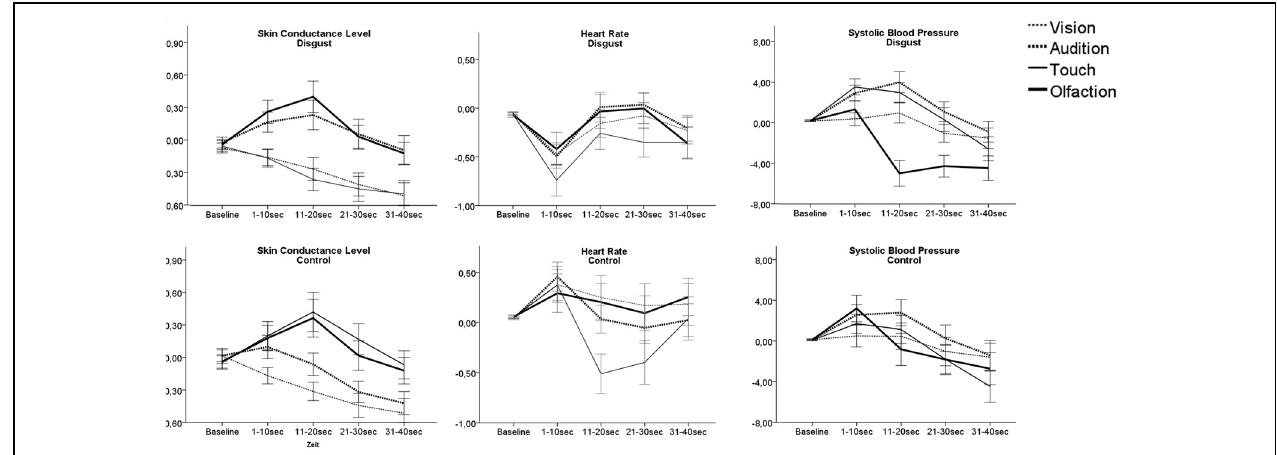
FIGURE 3 | Autonomic responses as AuC following presentation of disgusting and control stimuli. Lines show mean response of the participants toward the three disgusting stimuli applied through each sense.